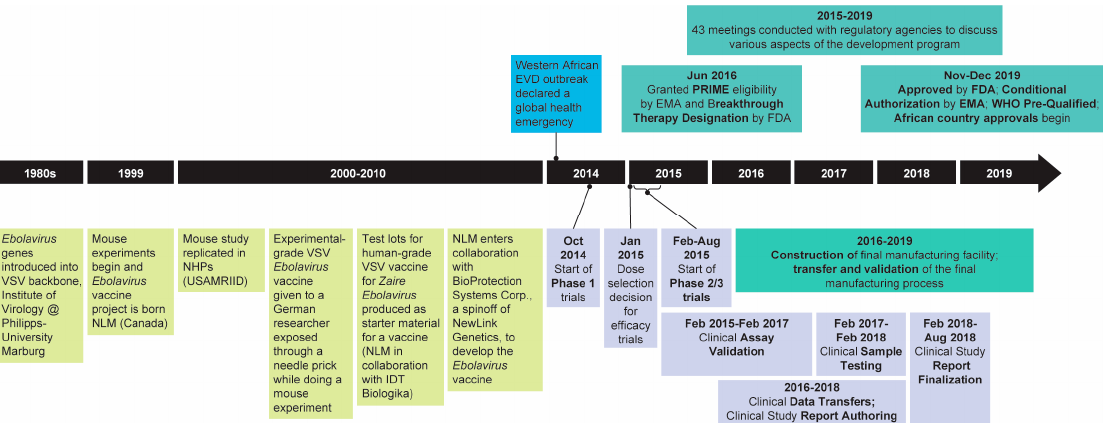
Figure 1. Timeline of Zaire Ebolavirus vaccine development beginning with Ebolavirus gene introduction into the VSV backbone in the 1980s through the European Medicines Agency (EMA) and the United States Food and Drug Administration (FDA) approval, WHO prequalification, and approval in African countries in 2019. EMA = European Medicines Agency; EVD = Zaire ebolavirus disease; FDA = United States Food and Drug Administration; NHPs = non-human primates; NLM = National Laboratory of Microbiology; USAMRIID = United States Army Medica Research Institute of Infectious Diseases; VSV = vesicular stomatitis virus; WHO = World Health Organization. Adapted from